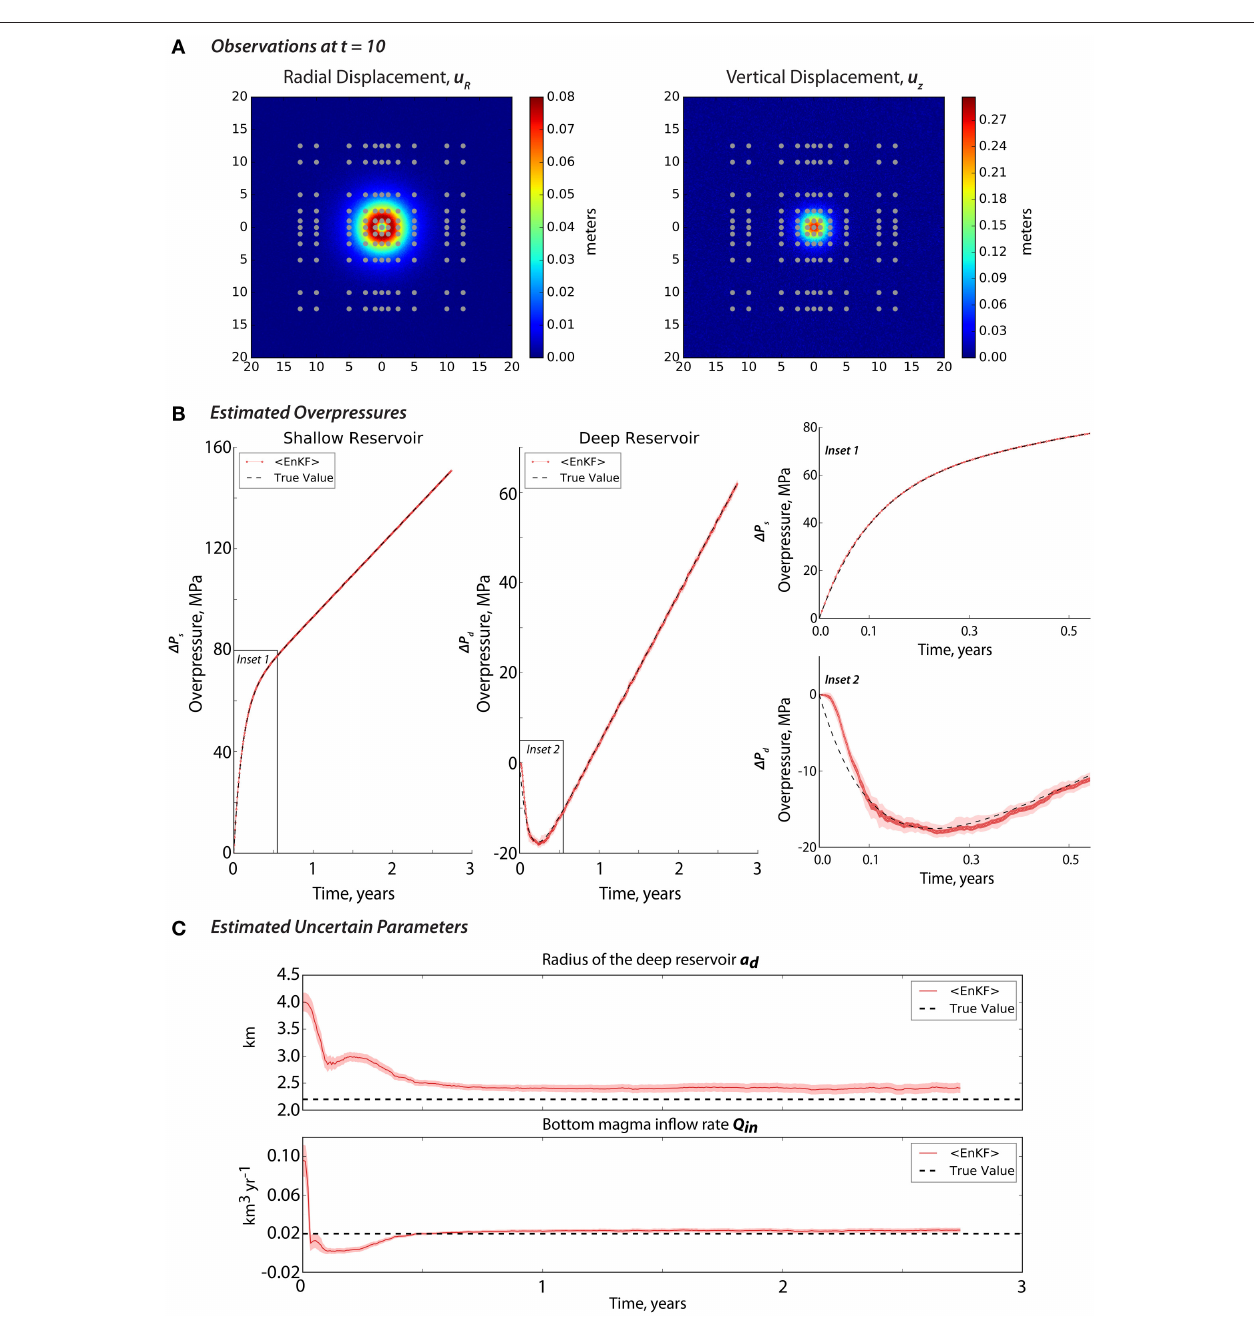
FIGURE 13 | (A) The locations of the 242 observations (i.e., 121 radial and 121 vertical points) in gray dots and their corresponding displacement values at t The observations are assimilated every time-step such that f obs 1. Note that the x and y axis are in kilometers. The EnKF-estimated (B) overpressures and (C) = uncertain parameters after performing state-parameter estimation using the observations in (A) . We used a biased prior distribution for the uncertain parameters like in Figure 5C or Figure 7C . Note that the pink shades represent the spread (1 σ ) of the estimation. The true values are the black broken lines.